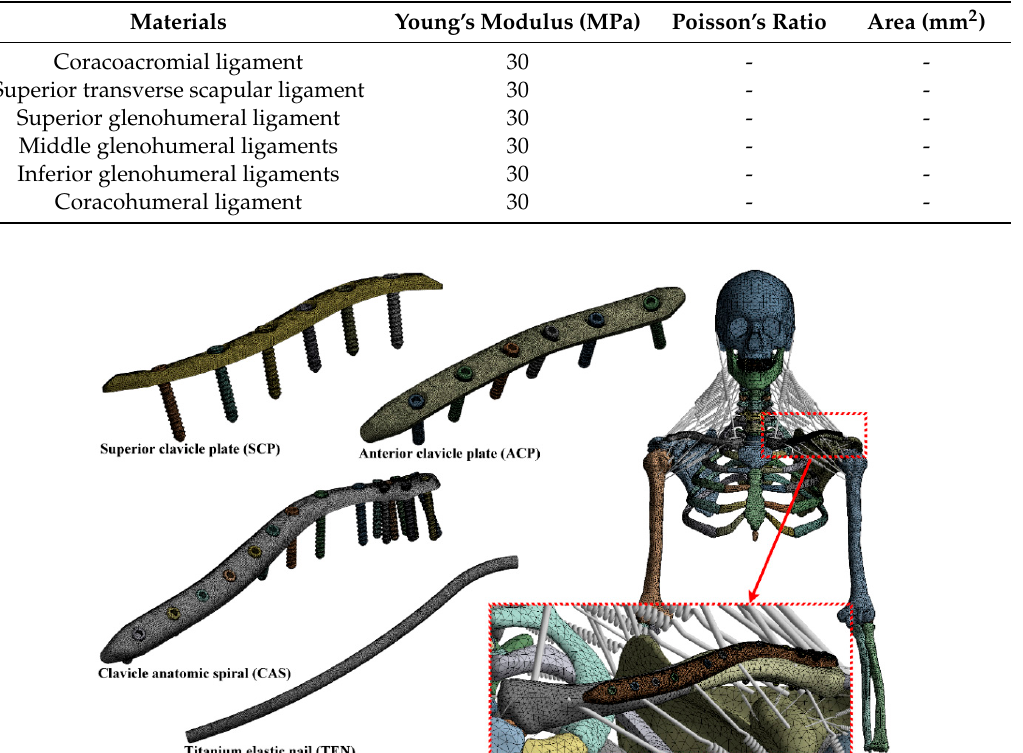
Figure 3. The meshed finite element models.